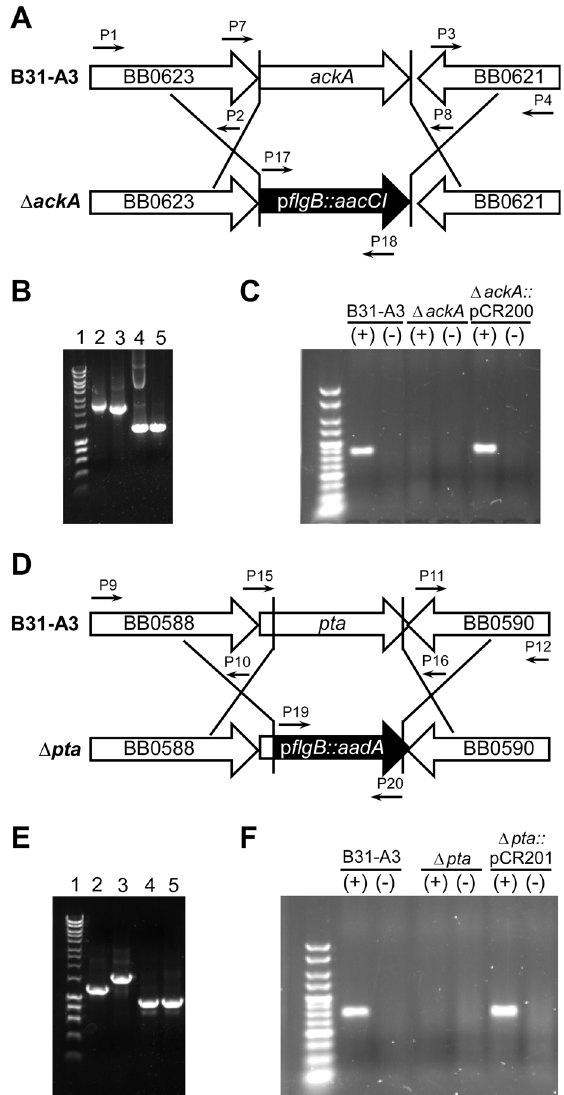
Fig 3. Generating the Δ ackA and Δ pta mutants. (A) and (D) Schematic representations of the allelic exchange events that were used to delete ackA and pta , respectively. (B) PCR of genomic DNA isolated from B . burdorferi strain B31-A3, Δ ackA or Δ ackA ::pCR200. Lane 1: Hyperladder I, Lanes 2 and 3: the ackA locus was amplified from DNA from strain B31-A3 (lane 2) or Δ ackA (lane 3) using primers P1 and P4. Lanes 4 and 5: the gentamicin resistance gene, aacC1 , was amplified from DNA isolated from Δ ackA (lane 4) or Δ ackA :: pCR200 (lane 5) using primers P17 and P18. (C) RT-PCR on DNase treated RNA isolated from the designated strains using primers P21and P22. (+ or -) denotes reactions with or without reverse transcriptase. (E) PCR of genomic DNA isolated from strains B31-A3, Δ pta and Δ pta ::pCR201. Lane 1, Hyperladder I, Lanes 2 and 3, the pta locus amplified from genomic DNA from strain B31-A3 (lane 2) or Δ pta (lane 3) using primers P15 and P16. Lanes 4 and 5 the streptomycin resistance gene, aadA , was amplified using primers P19 and P20 from DNA from Δ pta (lane 4) and Δ pta ::pCR201 (lane 5). (F) RT-PCR on DNase treated RNA isolated from the designated strains using primers P23 and P24. (+ or -) denotes reactions with or without reverse